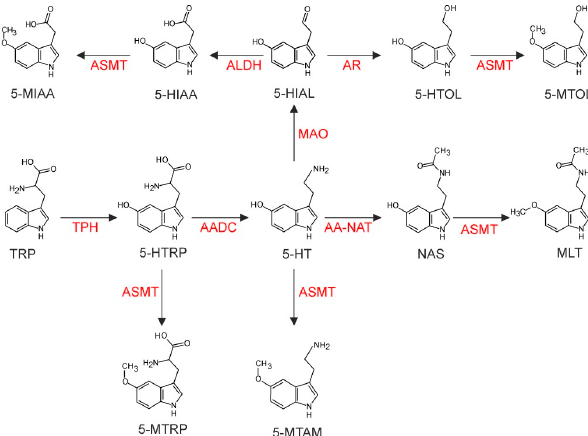
Figure A1. Metabolism of melatonin synthesis-related indoles in the pineal organ. Abbreviations: 5-HIAL, 5-hydroxyindole acetic aldehyde; ALDH, aldehyde dehydrogenase; AR, aldose reductase; MAO, monoamine oxidase; others – see the text above.